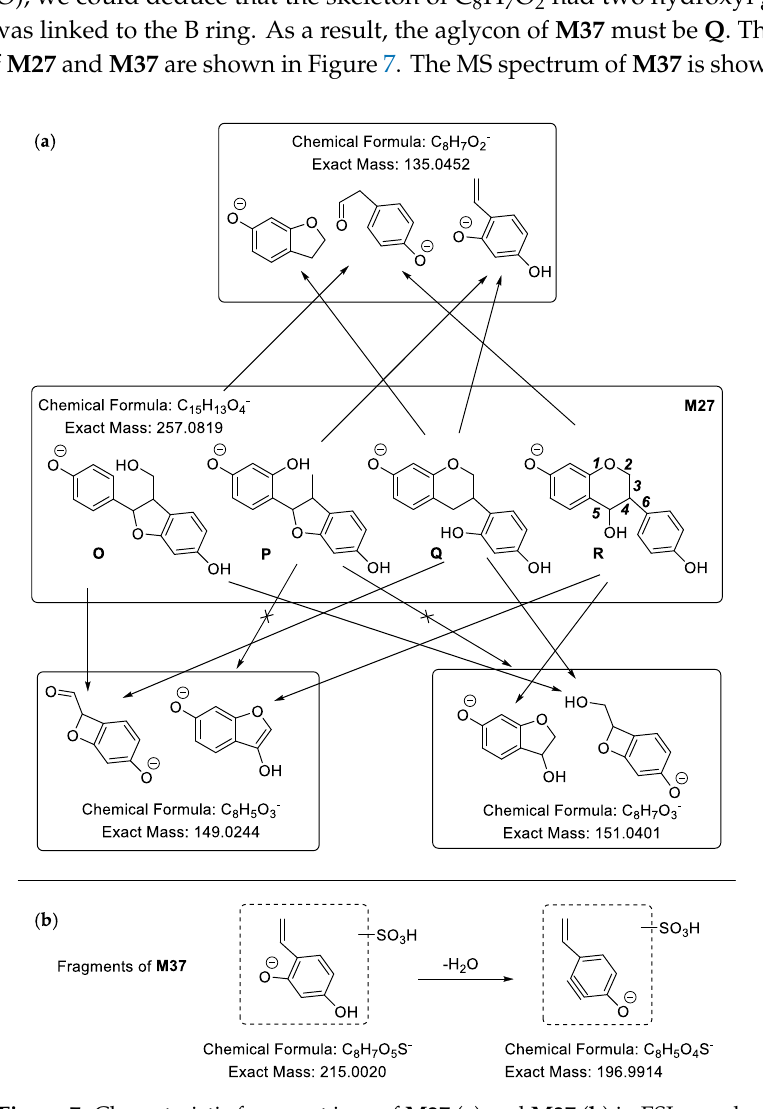
Figure 7. Characteristic fragment ions of M27 ( a ) and M37 ( b ) in ESI− mode.